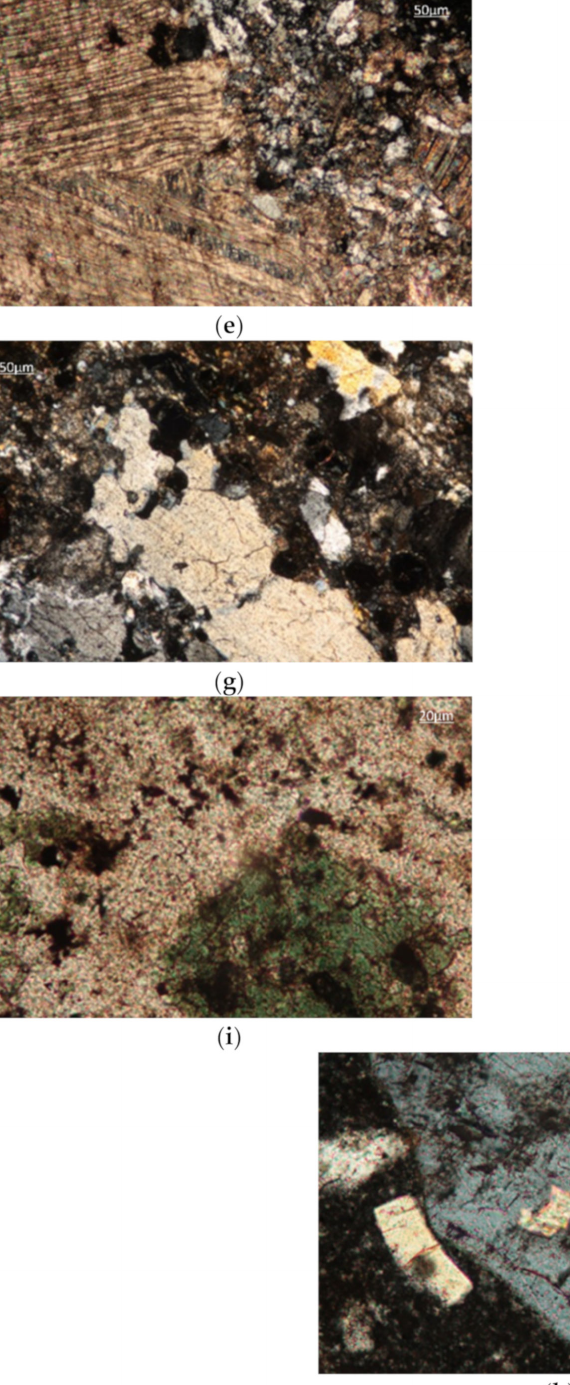
Figure 4. Photo imaging obtained by an optical transmitted light microscope at crossed nicols at 10 × magnification: ( a ) micrite limestone with sparitic calcite; ( b ) limestone with bioclasts of shells and fragments of shells and pellets; ( c ) crystalline calcite; ( d ) serpentinite. At 10 × magnification: ( e ) impure marble; ( f ) mylonites (plagioclase with undulated twinning from tectonic stress and fragments); ( g ) mylonites (quartz and k-feldspar with fragments); ( h ) porphyry that contains phenocrysts with resorption loops; ( i ) chlorite (50 × magnification); ( j ) microcrystalline alteration products around feldspar phenocrysts (possible oxides); ( k ) altered and fractured potassium